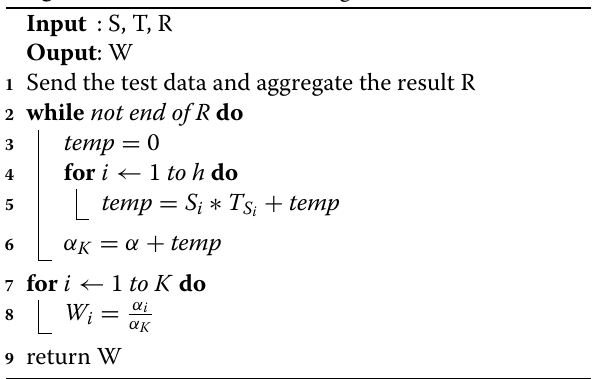
Algorithm 2: Feedback counting